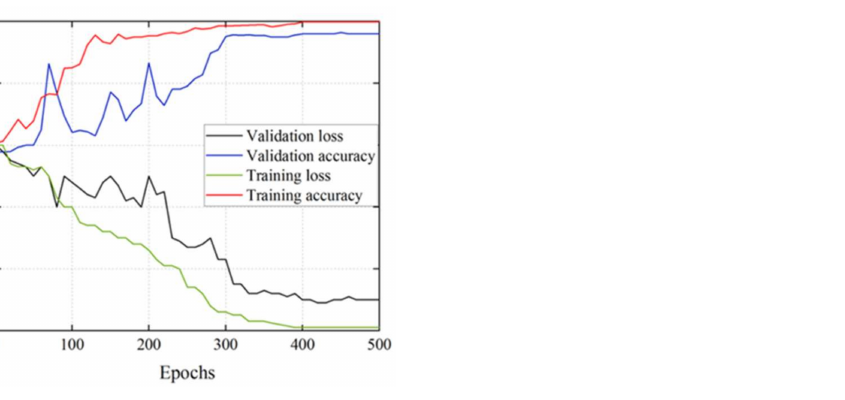
Figure 9. The training and validation performance of the CNN model in the RS dataset + DCGAN dataset at 500